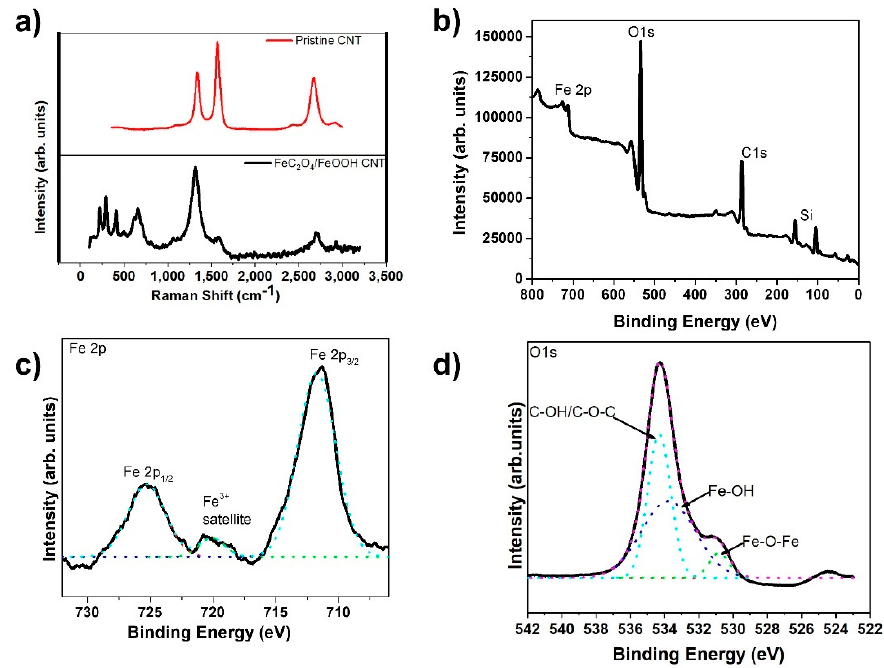
Figure 4. ( a ) Raman spectra of FeC 2 O 4 /FeOOH/CNT fiber; ( b ) XPS survey scan of FeC 2 O 4 /FeOOH/CNT fiber; ( c ) High Resolution spectra of Fe2p from ( b ); and ( d ) high resolution scan of O1s from ( b